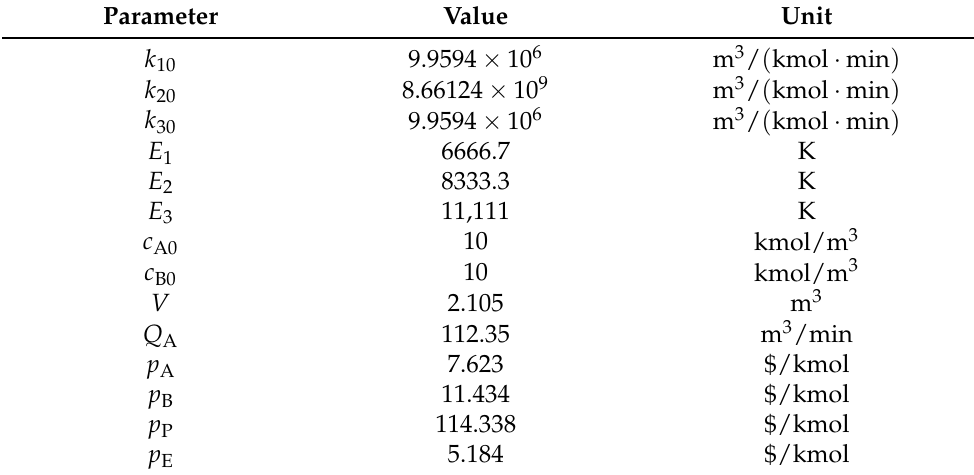
Table 1. William–Otto reactor: Plant parameters Parameter